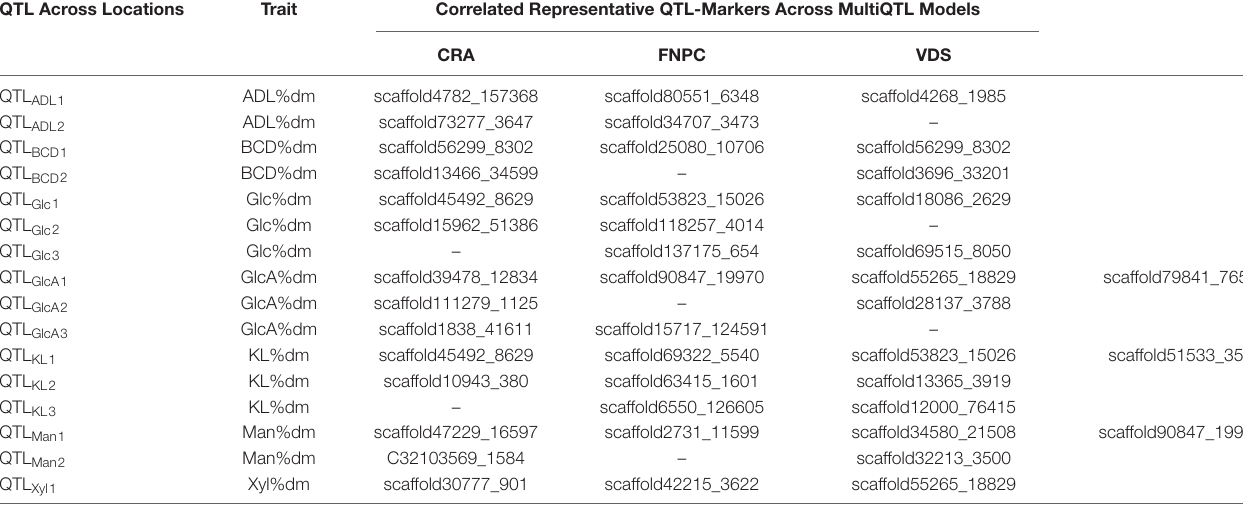
TABLE 3 | Identification of quantitative trait loci (QTL) regions across locations for seven fiber quality traits of hemp. QTL Across